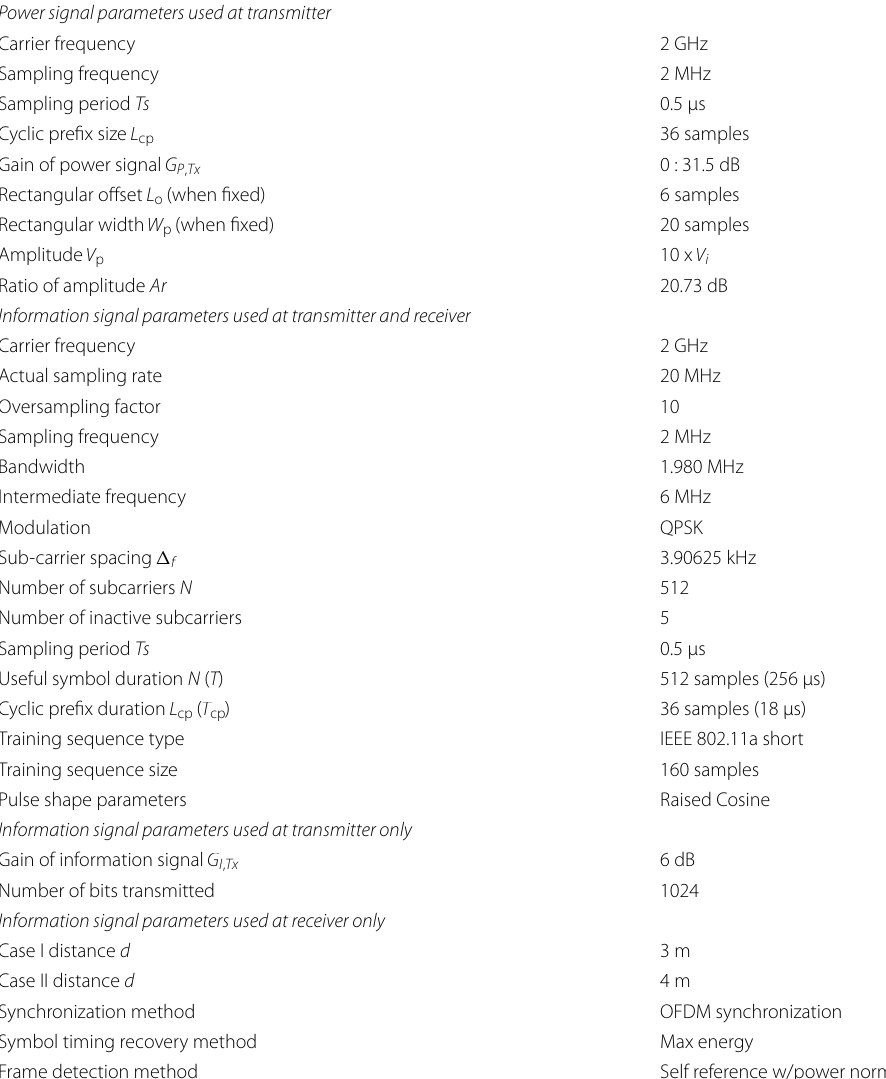
Table 2 Measurement parameters of WIT Power signal parameters used at